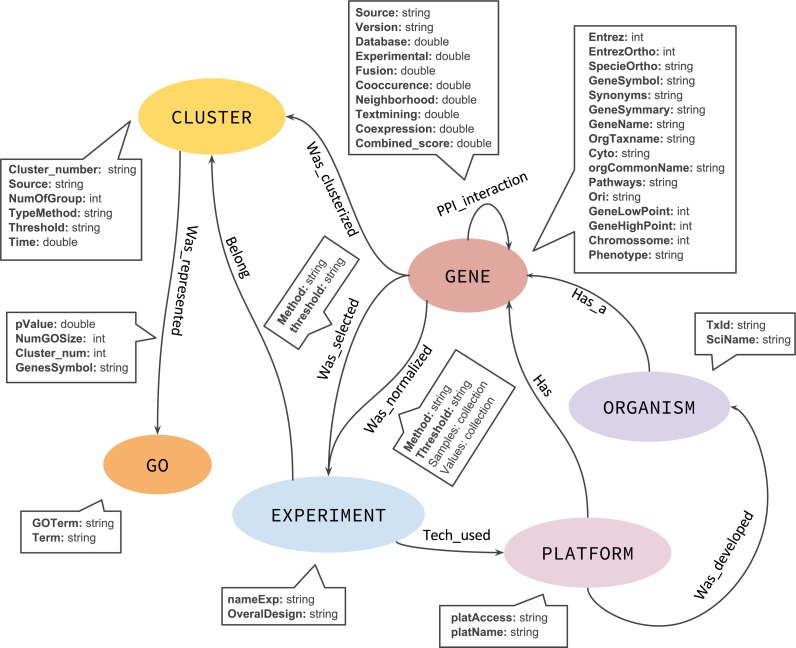
The graph model representing the nodes (in oval), relationships (arrows).The descriptive boxes showing the mainly properties in nodes and edges.